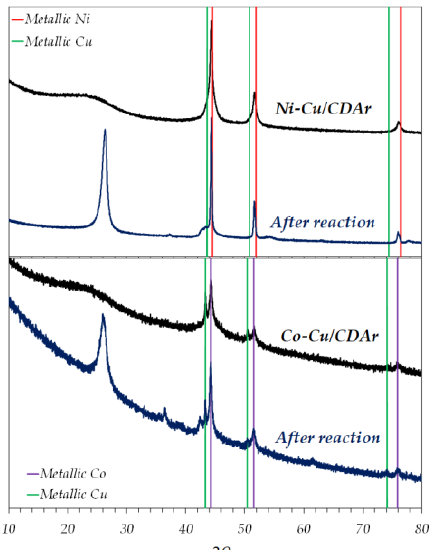
Figure 1. XRD patterns of fresh and used catalysts (800 °C; CH 4 /H 2 /N 2 (%): 28.6/14.3/57.1).